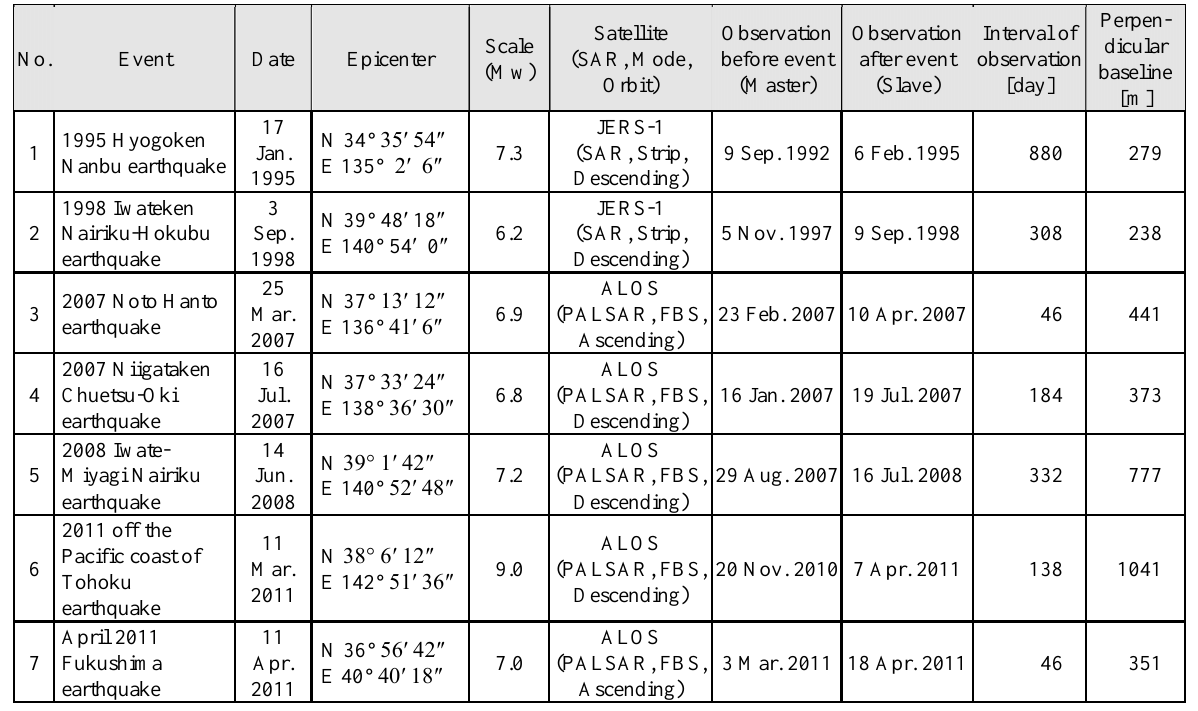
Table 2. List of events chosen as the teaching